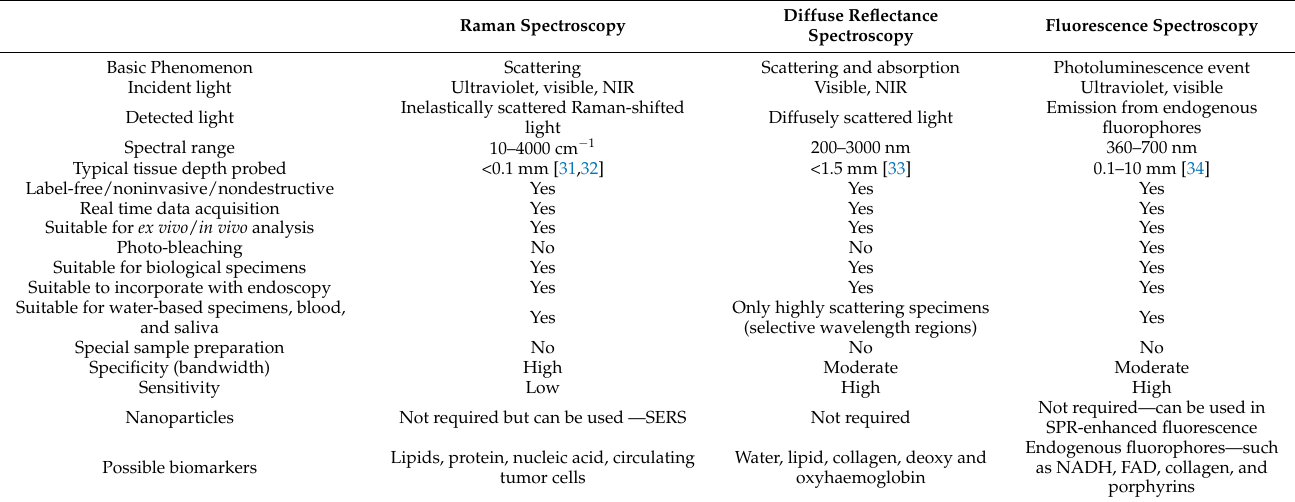
Table 2. General characteristics of RS, DRS, and FS in cancer